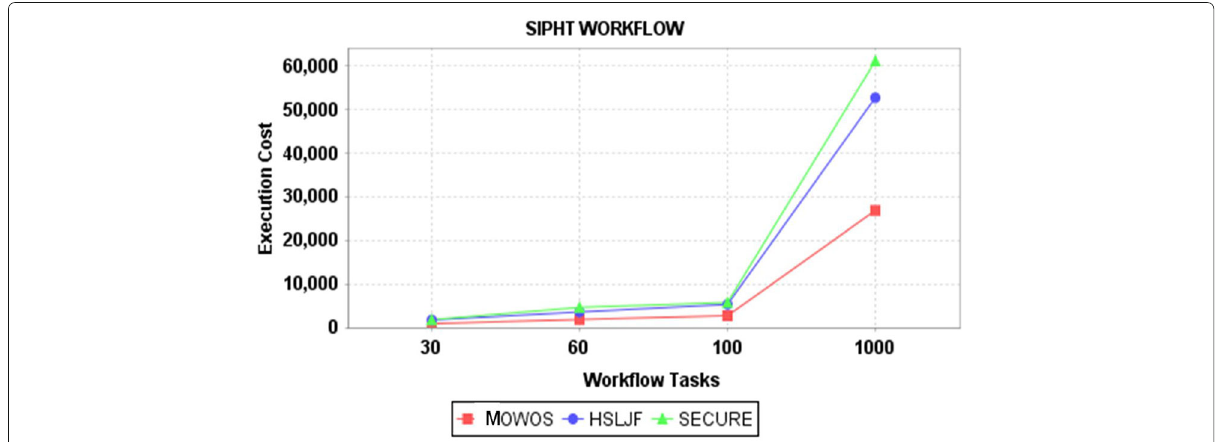
Fig. 7 Comparison of execution cost using SIPHT workflow